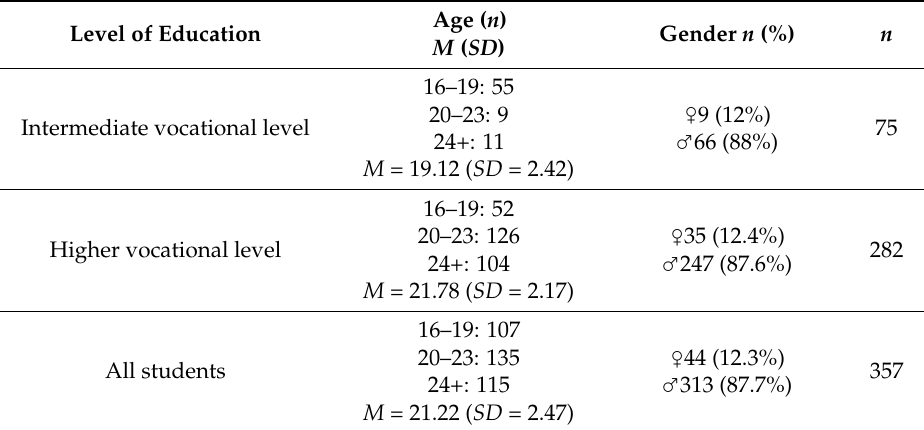
Table 1. Characteristics of participants ( N =